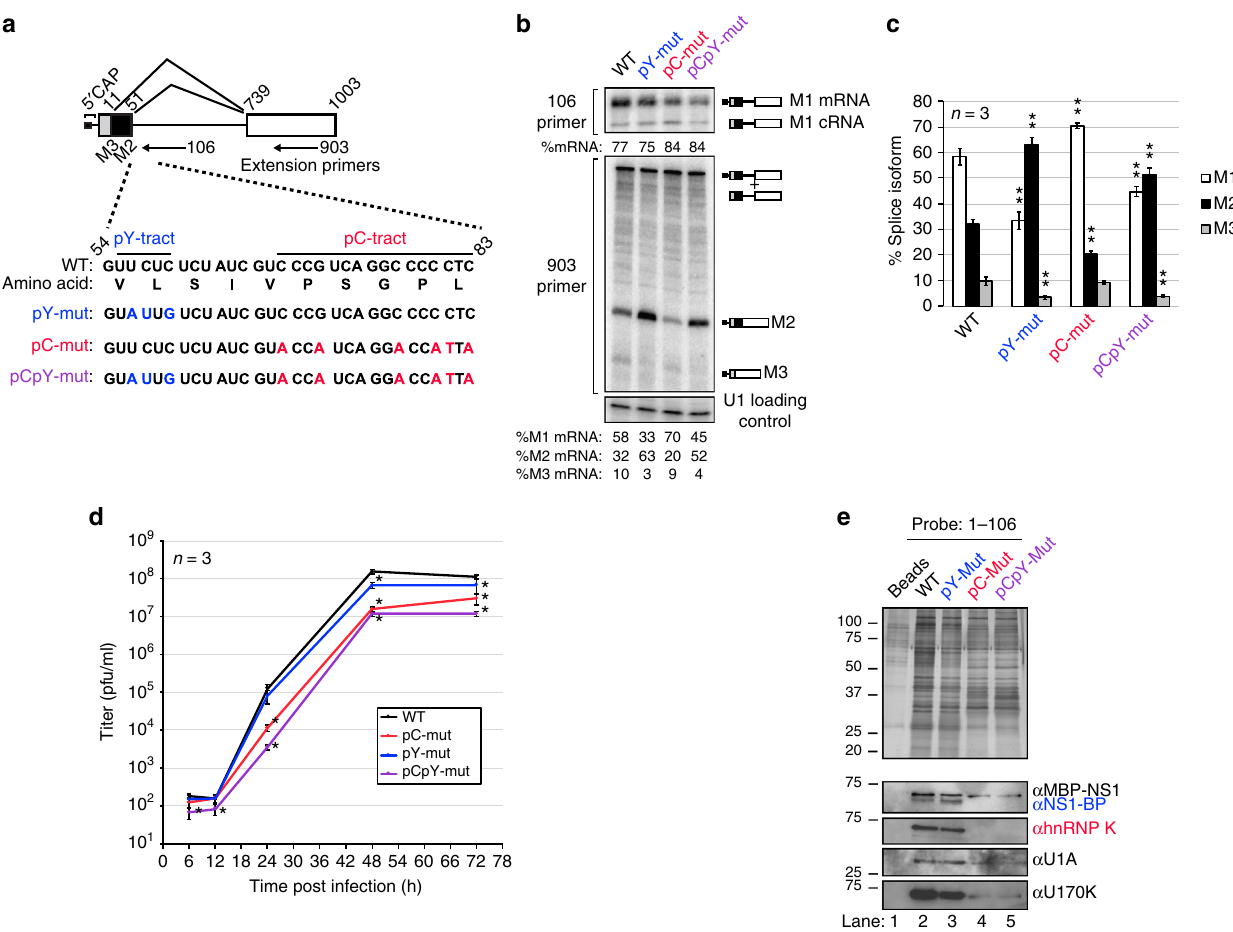
Fig. 4 hnRNP K and NS1-BP-binding sites differentially regulate IAV PR8 M segment splicing and replication. a Diagram of IAV PR8 M segment mRNA with possible splice isoforms and extension primer positions labeled. Labels are as in Fig. 1. b Primer extension of PR8 M segment antisense RNA after infection in A549 cells at moi = 2. Extension primers used are indicated on the left and band identities on the right of the gel image. c Quanti fi cation of mRNA primer extension products represented as percentage signal of each isoform relative to signal of total isoforms (M1 + M2 + M3). Values are means ± s.d. from three independent experiments. Statistical signi fi cance was determined via two-tailed student ’ s t test, where * p < 0.1 and ** p < 0.05 when comparing mock vs siRNA samples. d A549 cells were infected with WT and mutant PR8 at moi = 0.01 and assayed for plague forming units over 72 h. Values are means ± s.d. from three independent experiments. * p < 0.05. e RNA af fi nity puri fi cation of proteins bound to baits: 1 – 106 WT, 1 – 106 pY-mut, 1 – 106 pC-mut, 1 – 106 pCpY-mut (diagram of probes in Fig. 3a). RNA probes were incubated in JSL1 nuclear extract supplemented with recombinant, MBP-tagged NS1 and isolated with streptavidin beads. Bead eluates were resolved via SDS-PAGE and either silver stained (top panel) or immunoblotted for speci fi c proteins (bottom panels). Molecular weights are indicated to left of each blot. Uncropped gels shown in Supplementary Fig. 5.